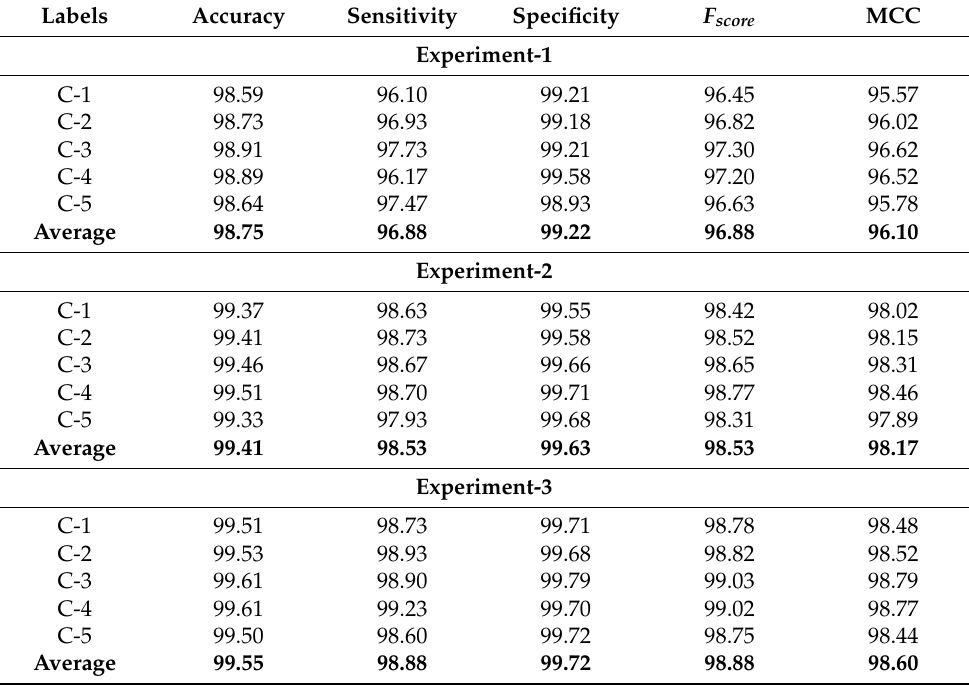
Table 2. Result analysis of AOEDBC-DL system with distinct measures and class